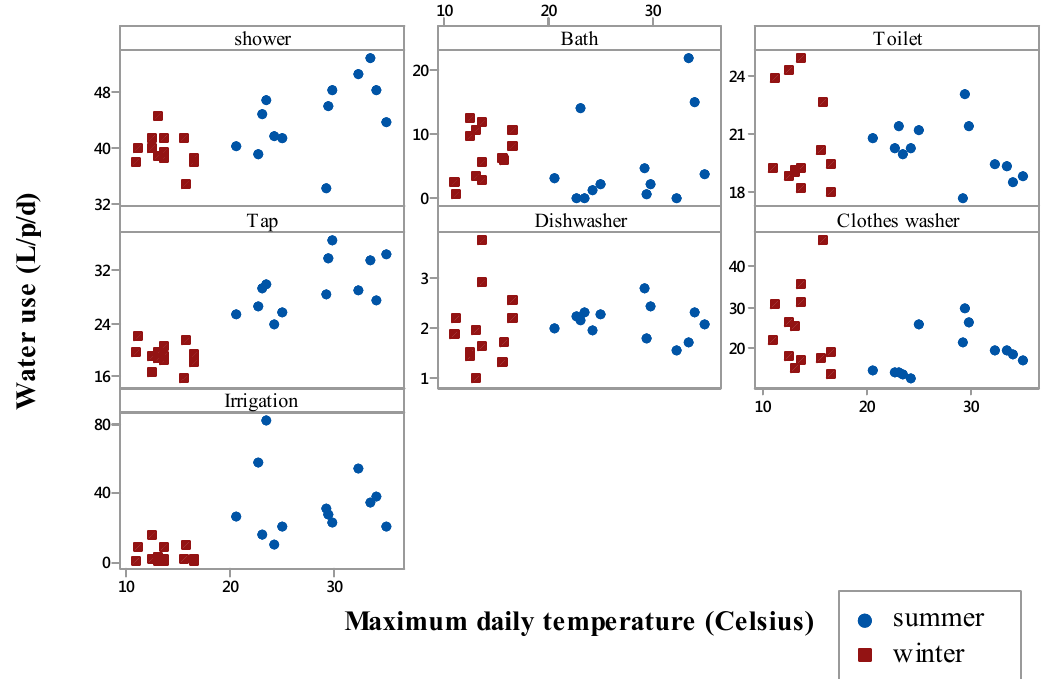
Figure 2. Scatter plots of water end-use volumes and maximum daily temperature categorised by season for CWW